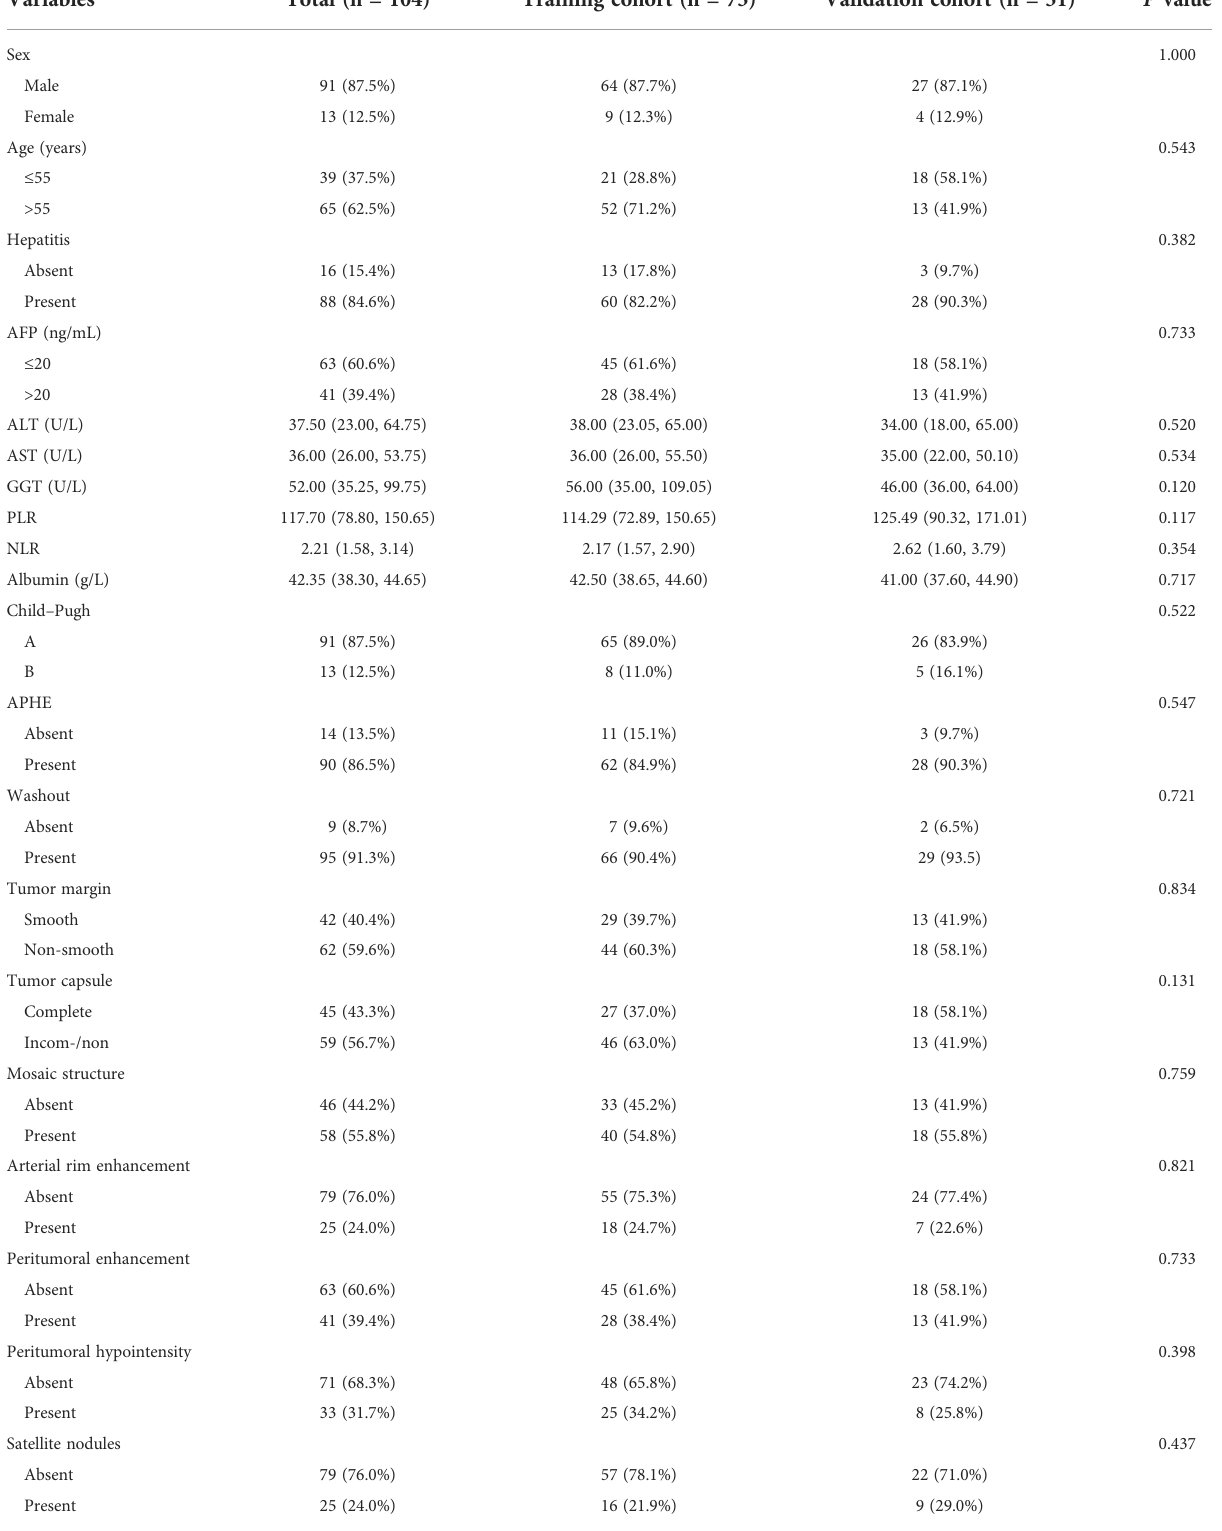
TABLE 2 Baseline characteristics between patients in the internal training and validation